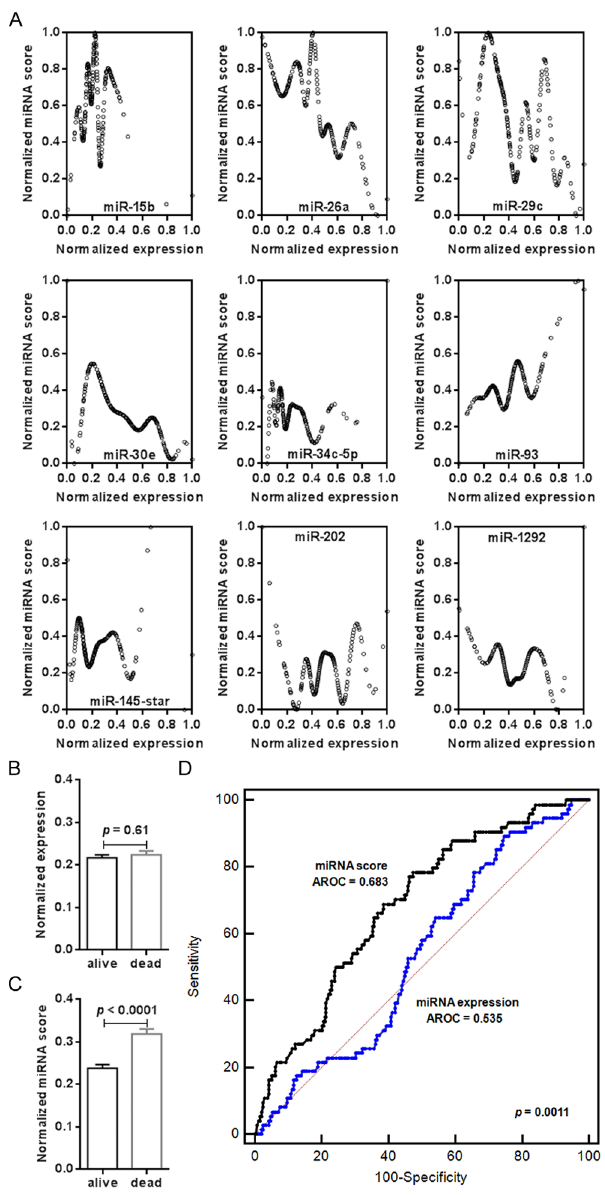
Figure 2. miRNA expression is non-linearly related with NPC patient death risk. A) Illustration of the relationship between normalized miRNA expression and normalized miRNA scores of the selected nine miRNA biomarkers. B) No significant difference was observed in normalized miR-15b expression between patients with survival statuses of ‘alive’ and ‘dead’. Mean 6 SEM; p =0.61. C) The miRNA scores of miR-15b were significantly different when patients with survival statuses of ‘alive’ and ‘dead’ were compared. Mean 6 SEM; p , 0.0001. D) AUROC comparison between the death risk prediction models using miRNA expression and miRNA scores of miR-15b, respectively. A significant difference was found ( p =0.0011). doi:10.1371/journal.pone.0110537.g002 the nine miRNAs with the highest R values and discard the others. The normalized miRNA expression values and normalized miRNA scores of three miRNAs with the best Spearman R values (miR-29c, miR-34c-5p, and miR-93) were used to build the untransformed neural network models (UNN) and transformed neural network (TNN), respectively. Both models had the same